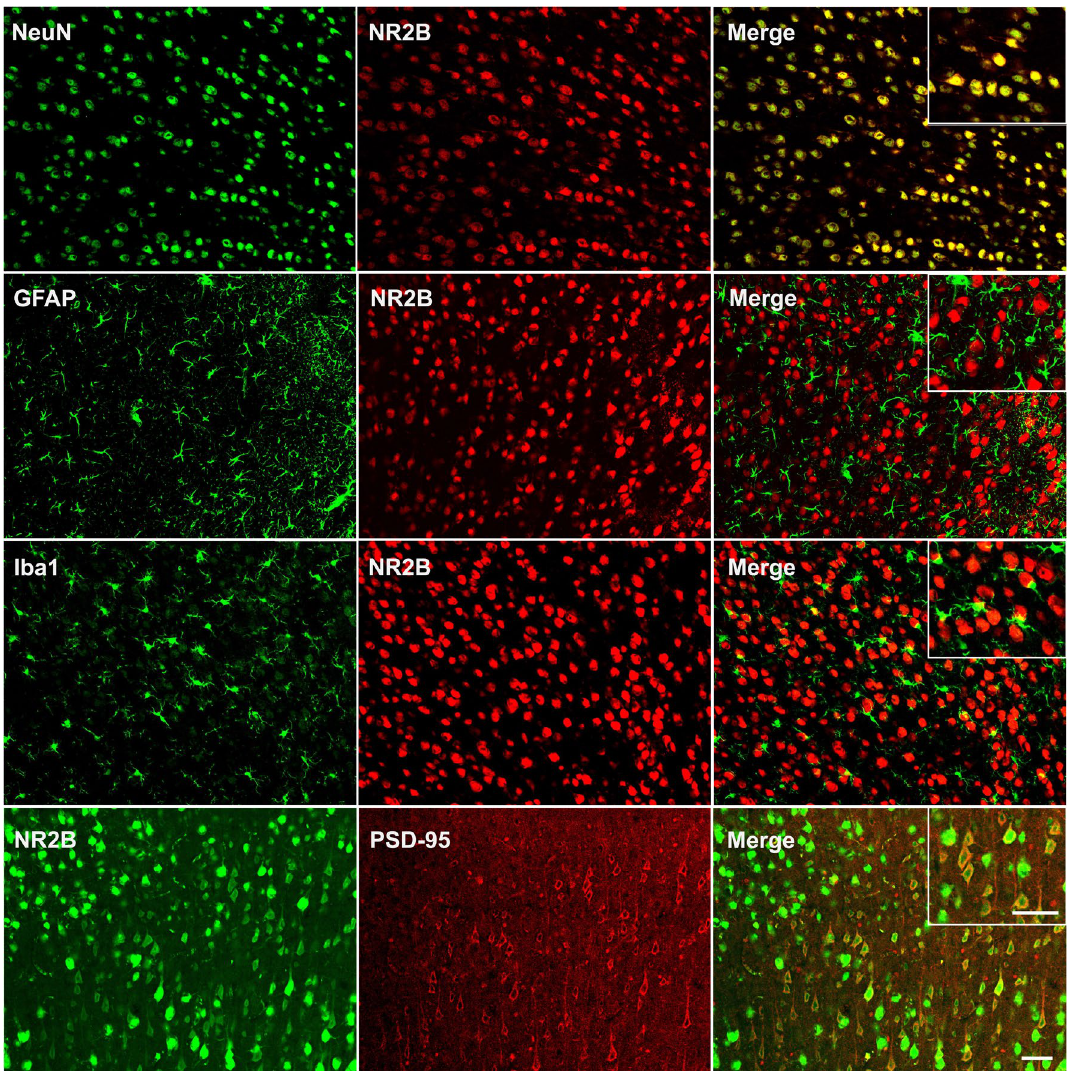
Figure 1. Cellular distribution of NR2B and PSD-95 in the anterior cingulate cortex. Double immunofluorescence staining shows colocalization of NR2B with NeuN and PSD-95, but not with GFAP or Iba1. Scale bar = 100 μm. NR2B: NMDA receptor subunit 2B; NeuN: neuron-specific nuclear protein; GFAP: glial fibrillary acidic protein; Iba1: ionized calcium-binding adaptor molecule-1; PSD-95: postsynaptic density